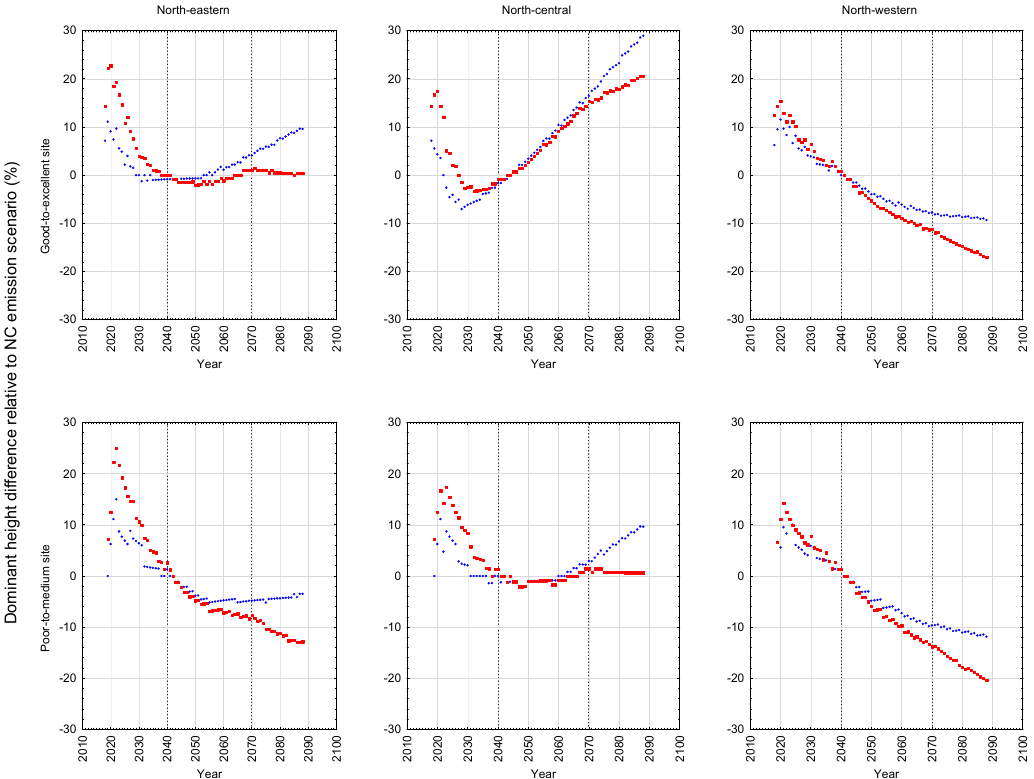
Figure 5. Dominant height developmental differences for black spruce plantations relative to the NC emission scenario (%) for the B1 (circle) and A2 (square) emission scenarios by site quality and locale. The vertical dotted lines denote termination of the first and second commitment periods (2040 and 2070, respectively).